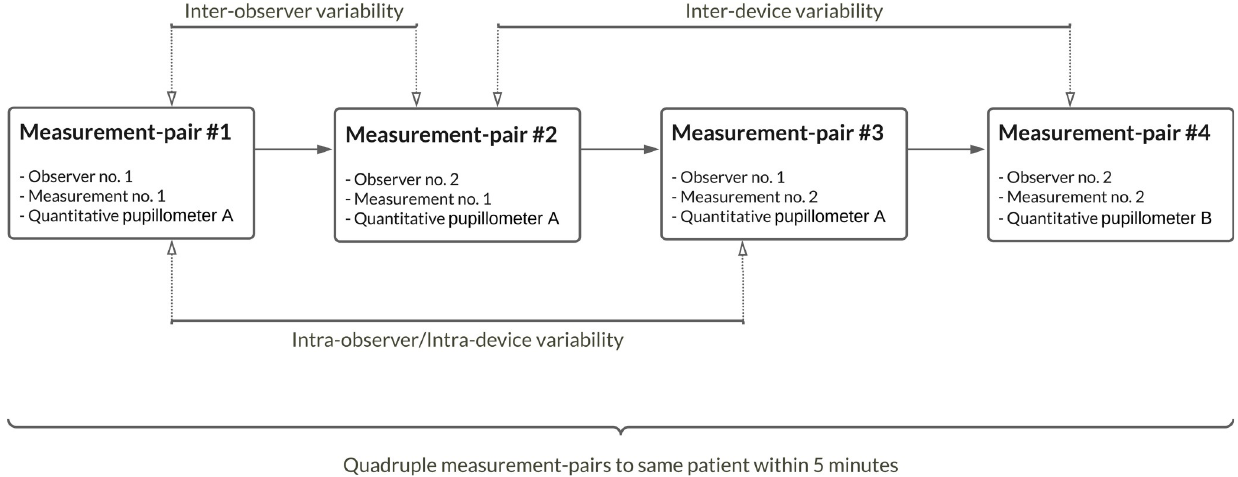
Fig 1. Patient assessment procedure. Flowchart of “Patient assessment procedure” depicting a complete set of quadruple measurement-pairs to the same patient within 5 minutes, with every measurement-pair comprising one manual, and one quantitative measurement, to both left and right eye, subsequently, blinded to the other